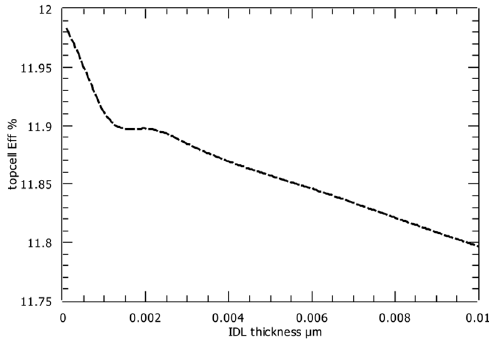
Figure 3. Interface defect layer (IDL) thickness vs. top cell efficiency.